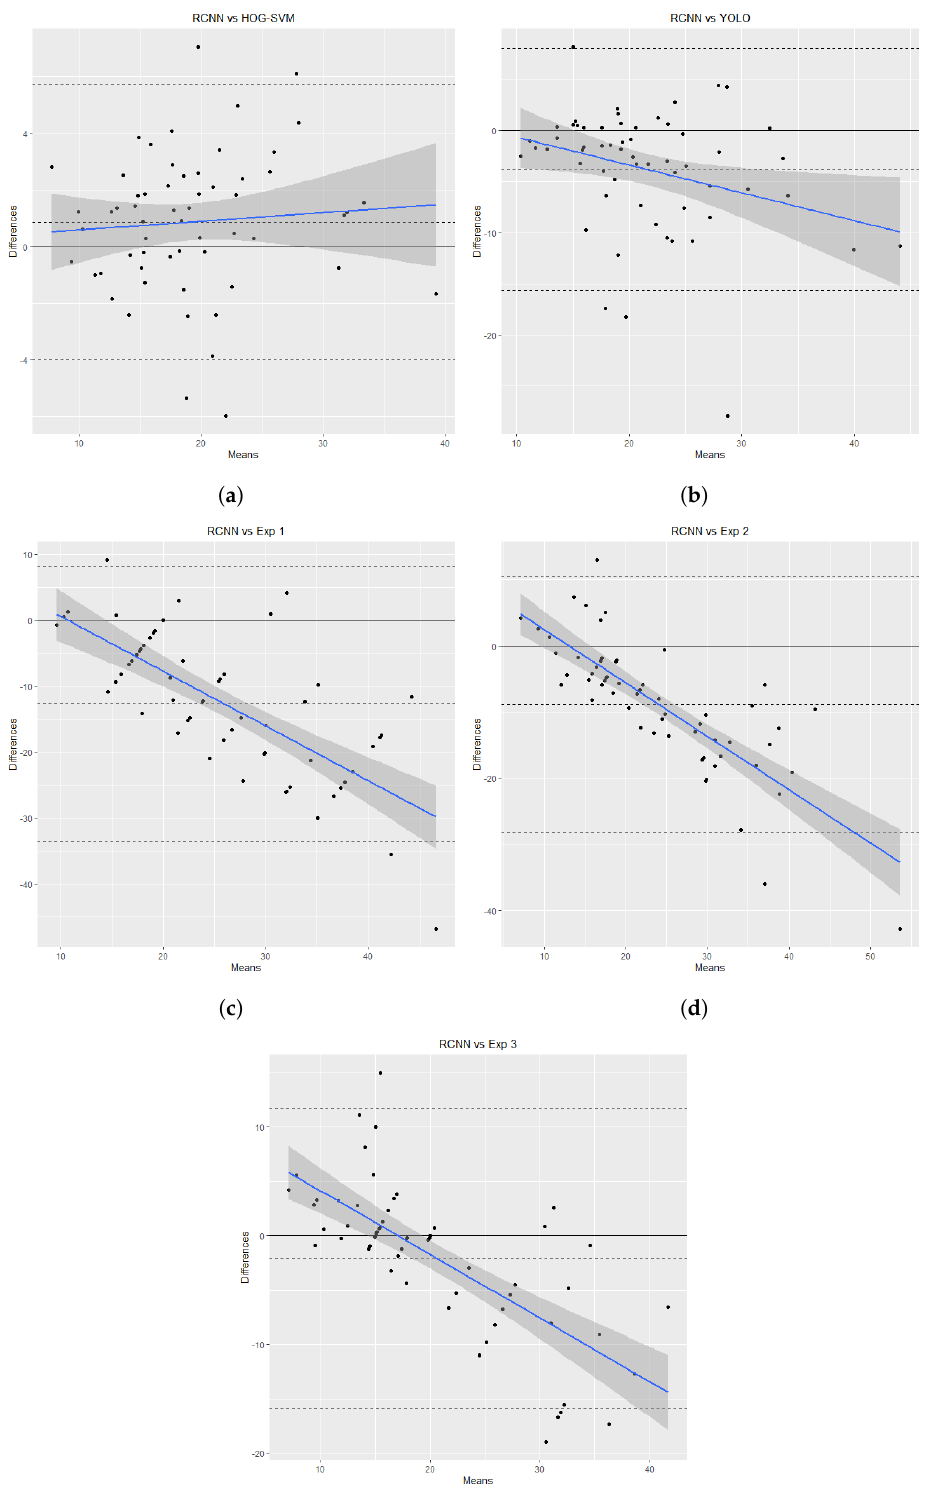
Figure 9. Bland–Altman Plots for machine–expert (human) and machine–machine methods in order to analyze the agreement between two weed estimations. ( a ) Method 1 (R-CNN) vs. method 3 (SVM); ( b ) method 1 (R-CNN) vs. method 2 (YOLO); ( c ) method 1 (R-CNN) vs. expert 1; ( d ) method 1 (R-CNN) vs. expert 2; ( e ) method 1 (R-CNN) vs. expert